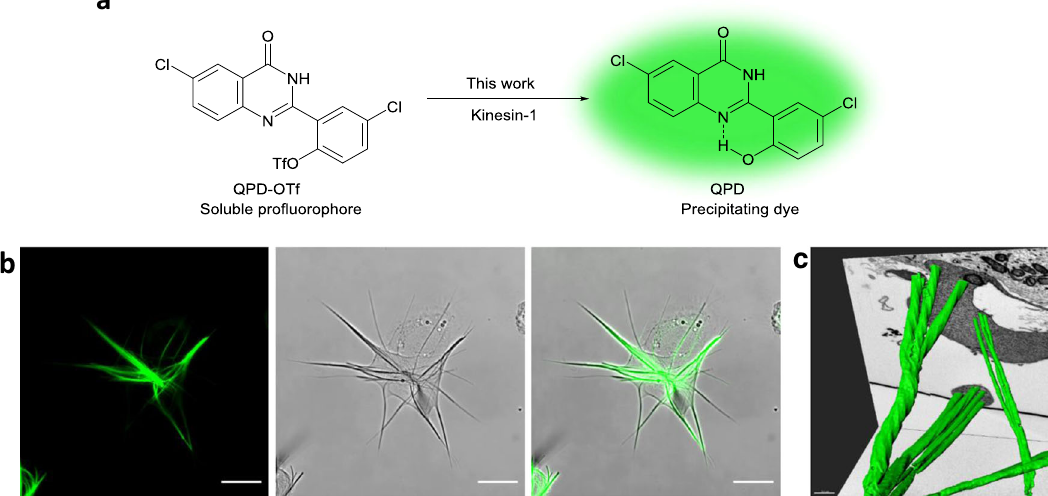
Fig. 1 Schema of the soluble pro fl uorophore QPD-OTf and the insoluble fl uorescent dye QPD and QPD crystal in cells. a Structure of QPD-OTf and QPD. b Aster-like QPD crystal in live U2OS cell (20 µ M QPD-OTf, 4 h); green: crystal. Left: QPD fl uorescence; middle: bright fi eld image; right: merged channels. Scale bar 20 µ m. c FIB-SEM 3D-reconstruction of the crystal inside HeLa cells; green: crystal. Scale bar 0.4 µ